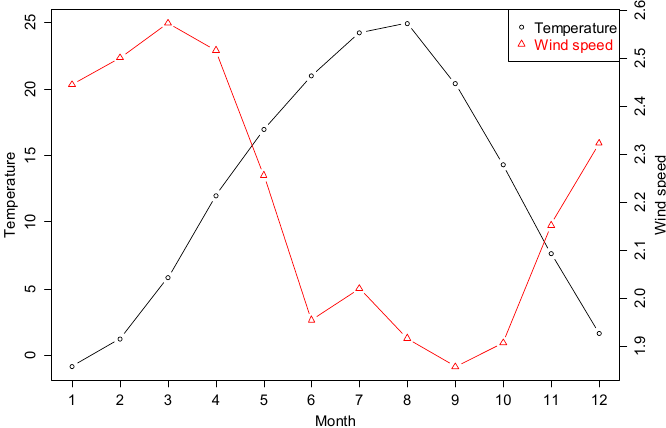
Figure 3. The monthly variations in outdoor temperature (°C) and wind speed ( m (cid:2870) /s ).